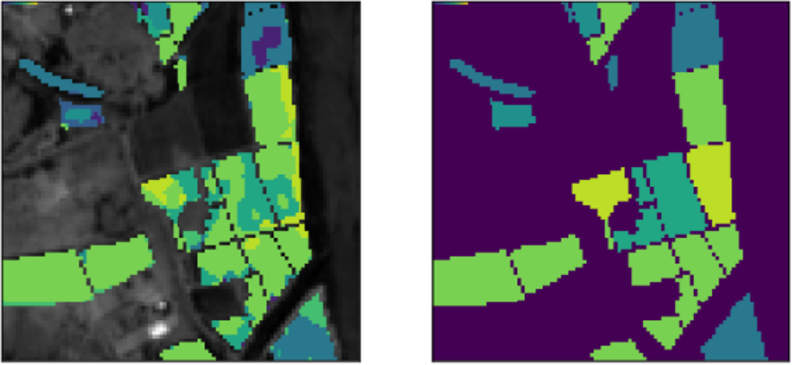
Figure 3. Classification map produced by U-Net+SE setup ( left ) and correct crop labels ( right ).